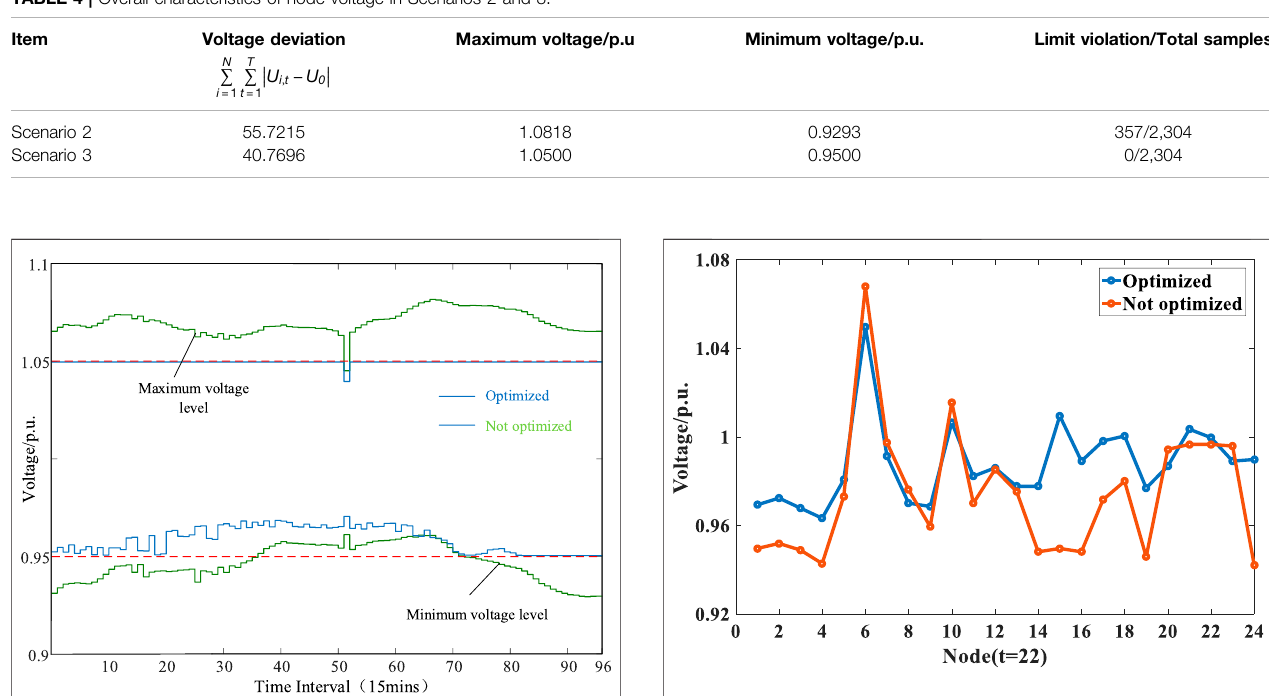
TABLE 4 | Overall characteristics of node voltage in Scenarios 2 and 3.